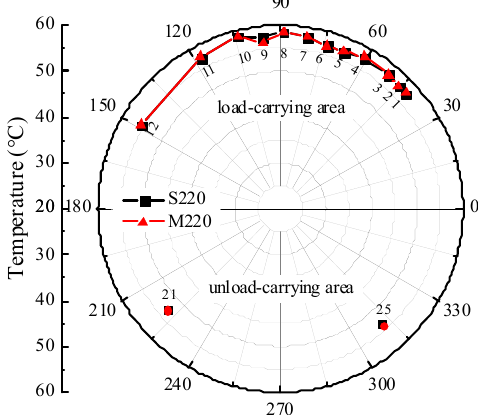
Figure 5. Circumferential temperature distribution in the mid ‐ plane of bearing at 200 rpm ‐ 6 MPa.